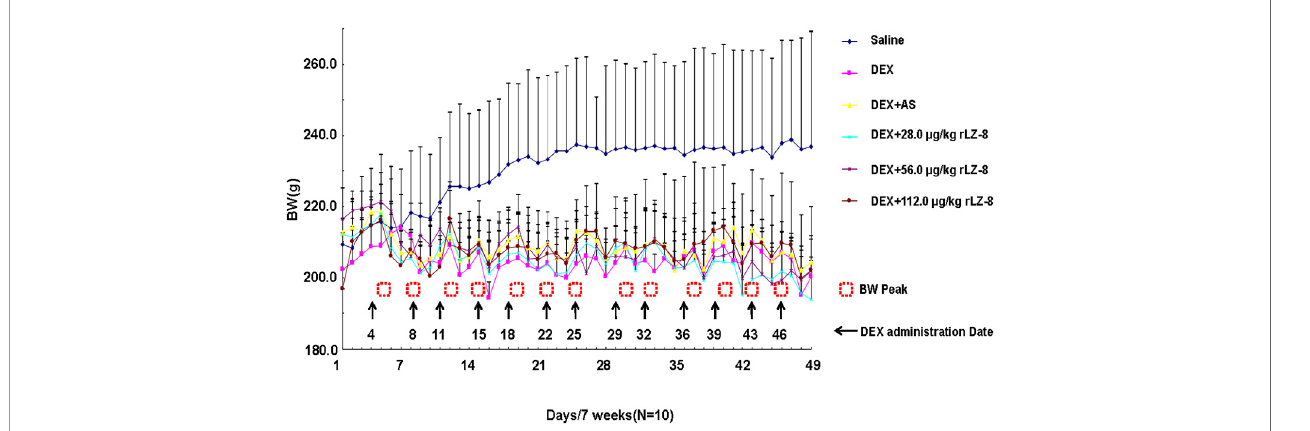
FIGURE 4 | Body weight change of the female Wistar rats within 7 weeks. The initial BWs of female rats in each group are similar and BWs of each rats was recorded daily for 49 days. Six curves with different color represent the BWs change in the six groups respectively. Arrows stand for the date receiving DEX and dashed squares stand for the peaks of BW. (BWs were presented as mean ± standard deviation).